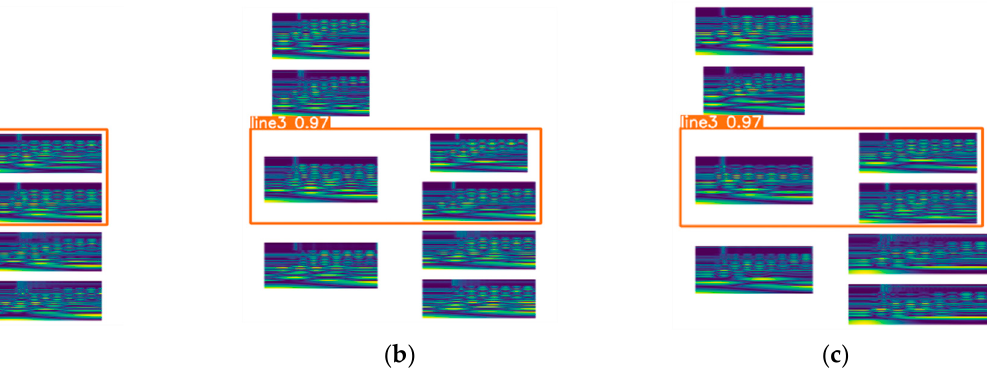
Figure 18. Grounding fault that occurred in Line 3: ground resistance of ( a ) 10 Ω ; ( b ) 500 Ω ; ( c ) 1500 Ω .